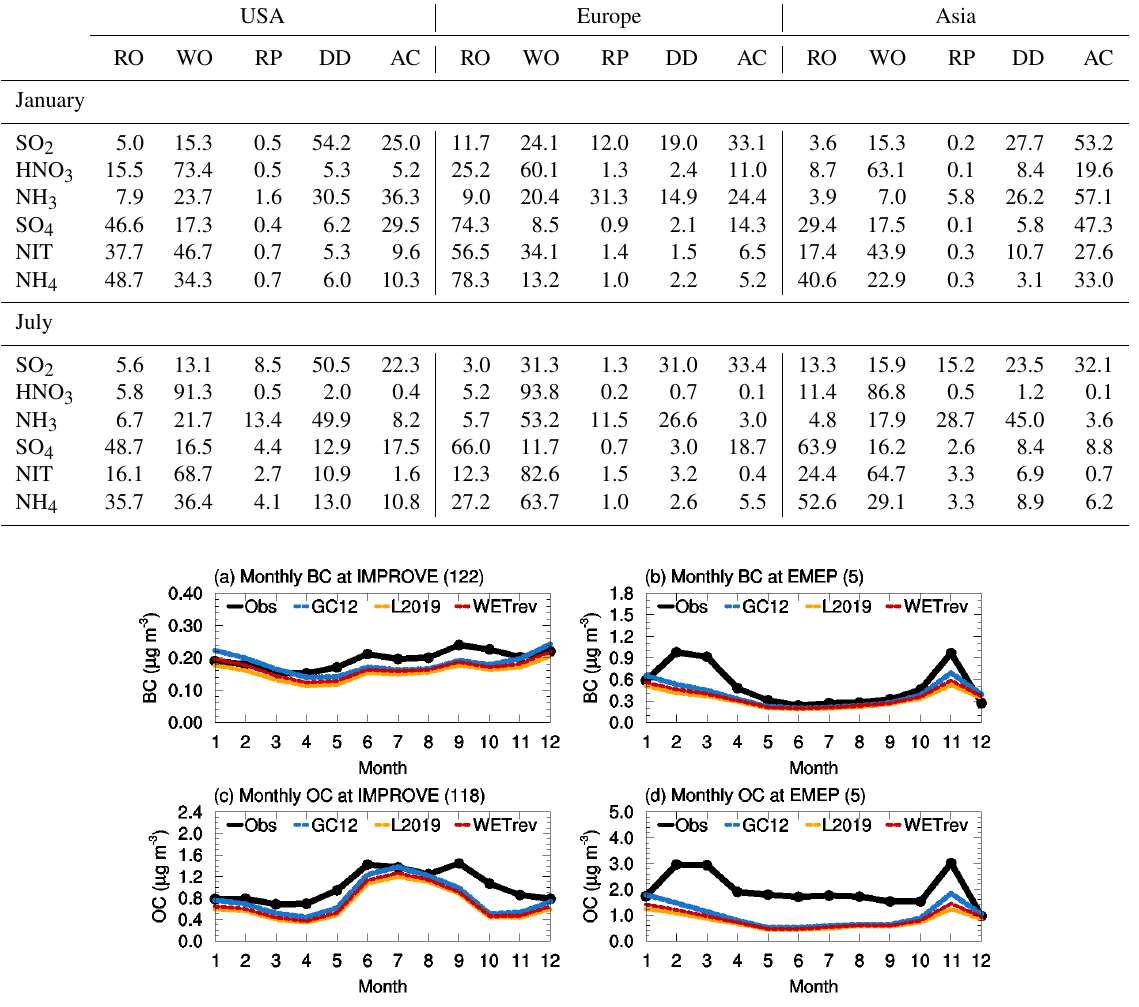
Table 4. Relative contribution (%) of modified rainout (RO), washout (WO), rain pH (RP), dry deposition (DD), and aqueous chemistry (AC) to the changes of January and July surface concentrations at the US, European, and Asian sites.